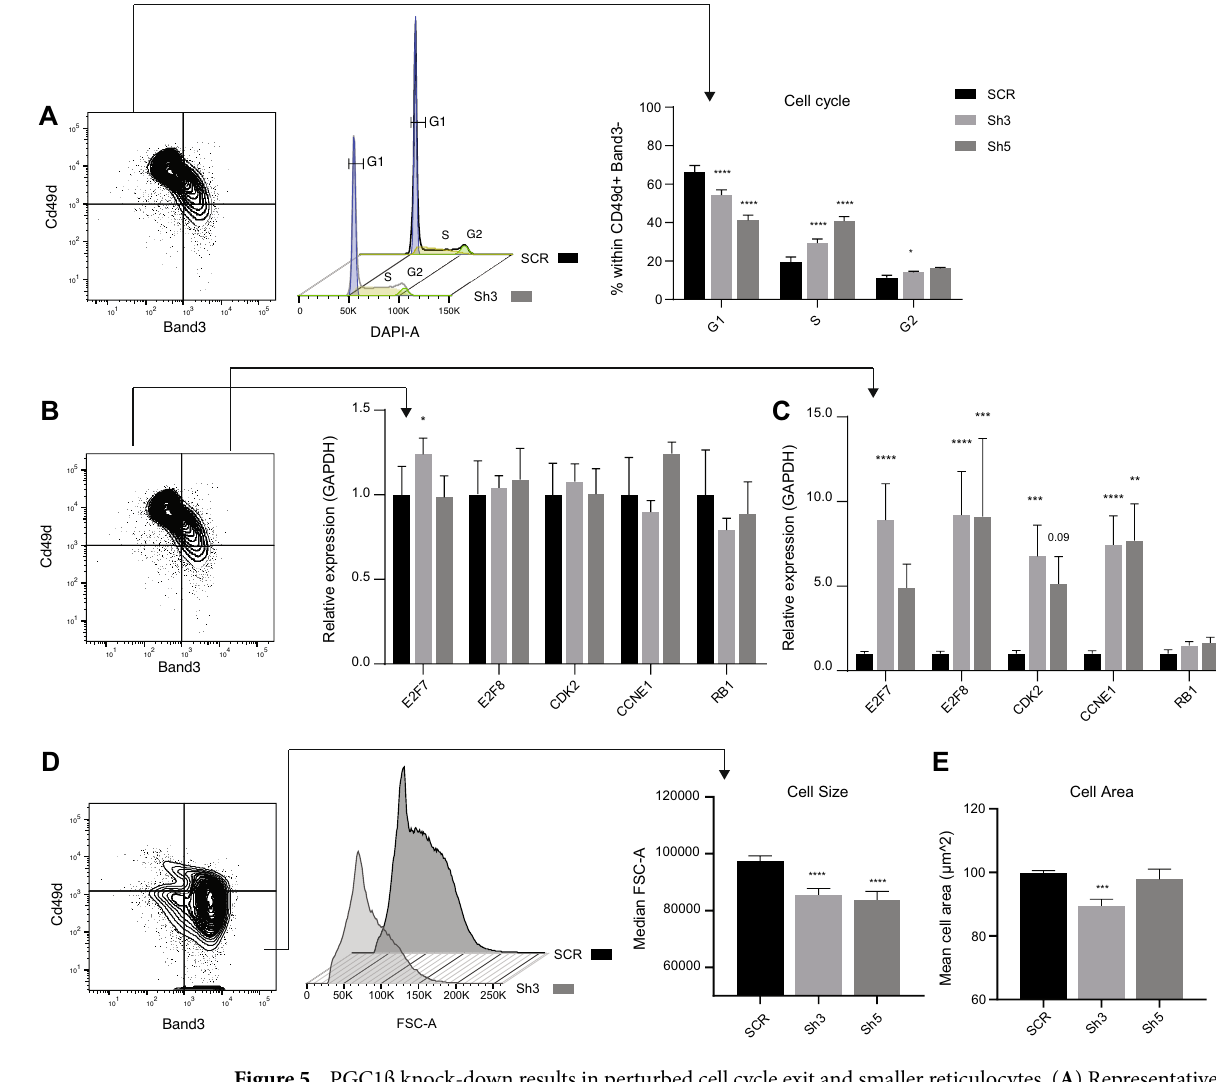
Figure 5. PGC1β knock-down results in perturbed cell cycle exit and smaller reticulocytes. ( A ) Representative plots indicating populations analyzed (SCR, left) and cell cycle profile (middle), and quantification (right) of the cell cycle status on d18 within bone marrow derived polychromatic erythroblast (CD49d + Band3 − ), using flow cytometry and DAPI (n = SCR:4, Sh3:12, Sh5:6). ( B , C ) Analysis of expression relative to GAPDH on day 18 of cell cycle related genes involved in G1 to S phase progression in ( B ) polychromatic erythroblasts (CD49d + Band − ), and ( C ) orthochromatic erythroblasts (CD49d + Band + ) using RT-qPCR (n = SCR:4 , Sh3:12, Sh5:6). ( D ) Representative plot indicating populations analyzed (SCR, left) and quantification (right) of cell size using flow cytometry and FSC-A within orthochromatic erythroblasts (CD49d - Band + ) on day 21 at the final stage in terminal differentiation. ( E ) 2D cell area quantification of enucleated cells (day 21) stained with DAB-Giemsa, using cytospin microscopy images and ImageJ software, (n = SCR:4, Sh3:12, Sh5:6). Data is presented as mean ± SEM (*P ≤ 0.05, **P ≤ 0.01, ***P ≤ 0.001, ****P ≤